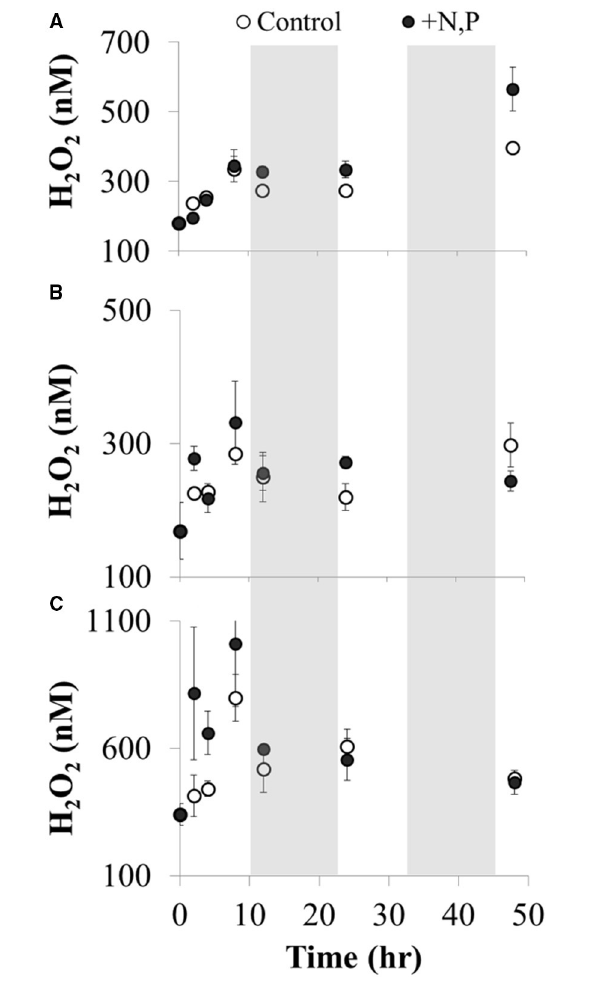
FIGURE 13 | H 2 O 2 concentrations vs. incubation time during microcosm experiments using Lake Erie water from three sites in the western basin of Lake Erie: (A) site 973 collected on 19 August 2014, (B) site 974 collected on 20 August 2014, and (C) site 973 collected on 3 September 2014. Water samples were incubated under natural sunlight and temperature on deck of the CCGS Limnos starting at 09:00h and ending 48h later. The shaded regions correspond to dark periods (night) during the experiment. The net rate of biological H 2 O 2 production was calculated as the slope of H 2 O 2 vs. time over the first eight h of the experiment ( p < 0.05 ) separately for control and amended waters in each water sample. All H 2 O 2 concentrations (nM) are plotted as average ± SE, n = 4 for each treatment and time